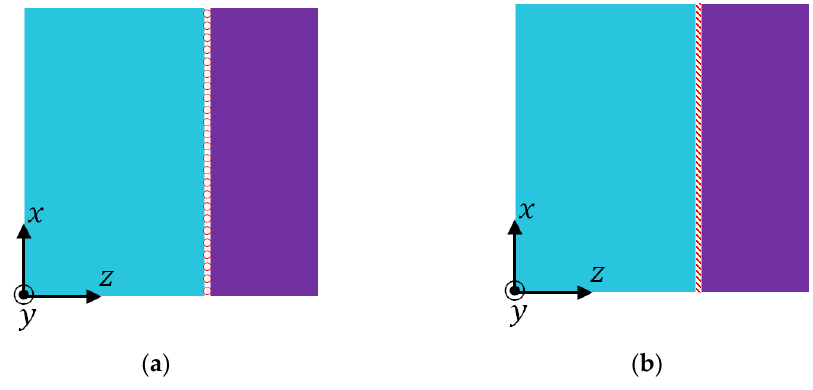
Figure 2. Models of phase interface. ( a ) Sliding; ( b ) bonded.